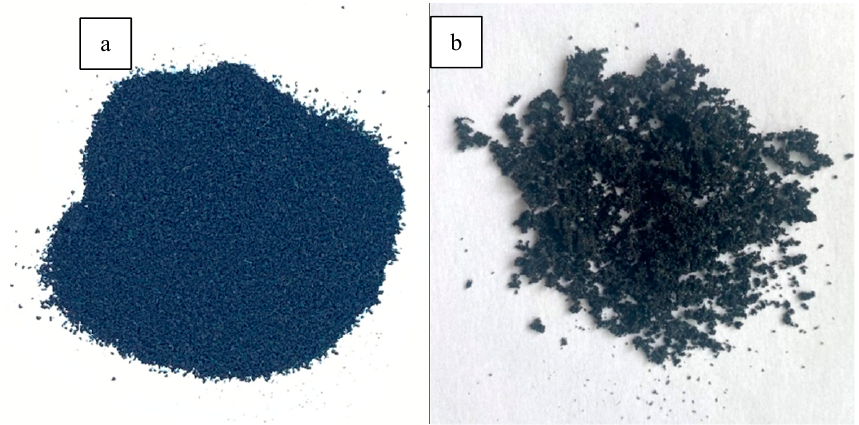
Figure 1. Macroimage of ( a ) CR and ( b ) SCR.